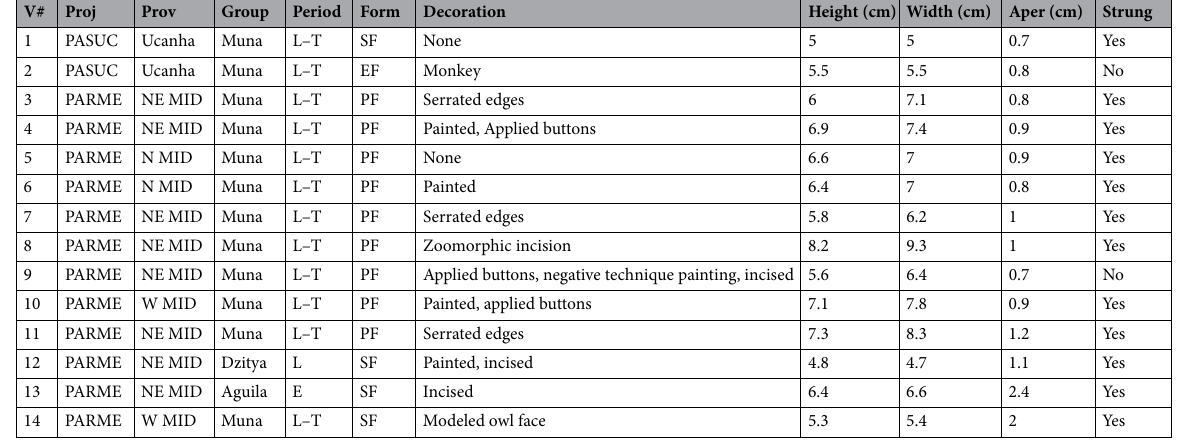
Table 1. PASUC and PARME vessels. NE MID Northeast of Mérida, N MID North of Mérida, W MID West of Mérida, L–T Late-Terminal Classic (AD 750–900), L Late Classic (AD 600–800), E Early Classic (AD 250–